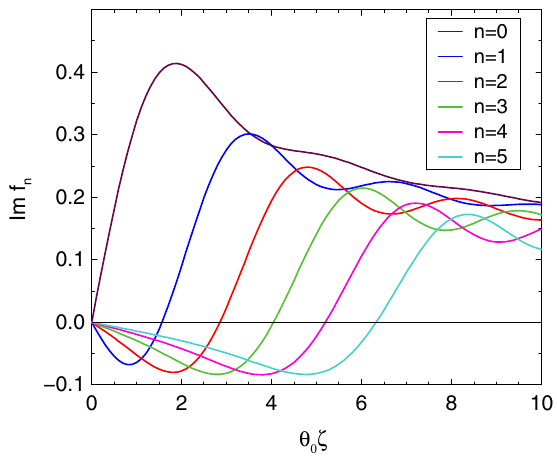
FIG. 5. Imaginary parts of the functions f tion to the instability growth rate as it is described by Eq. (20).